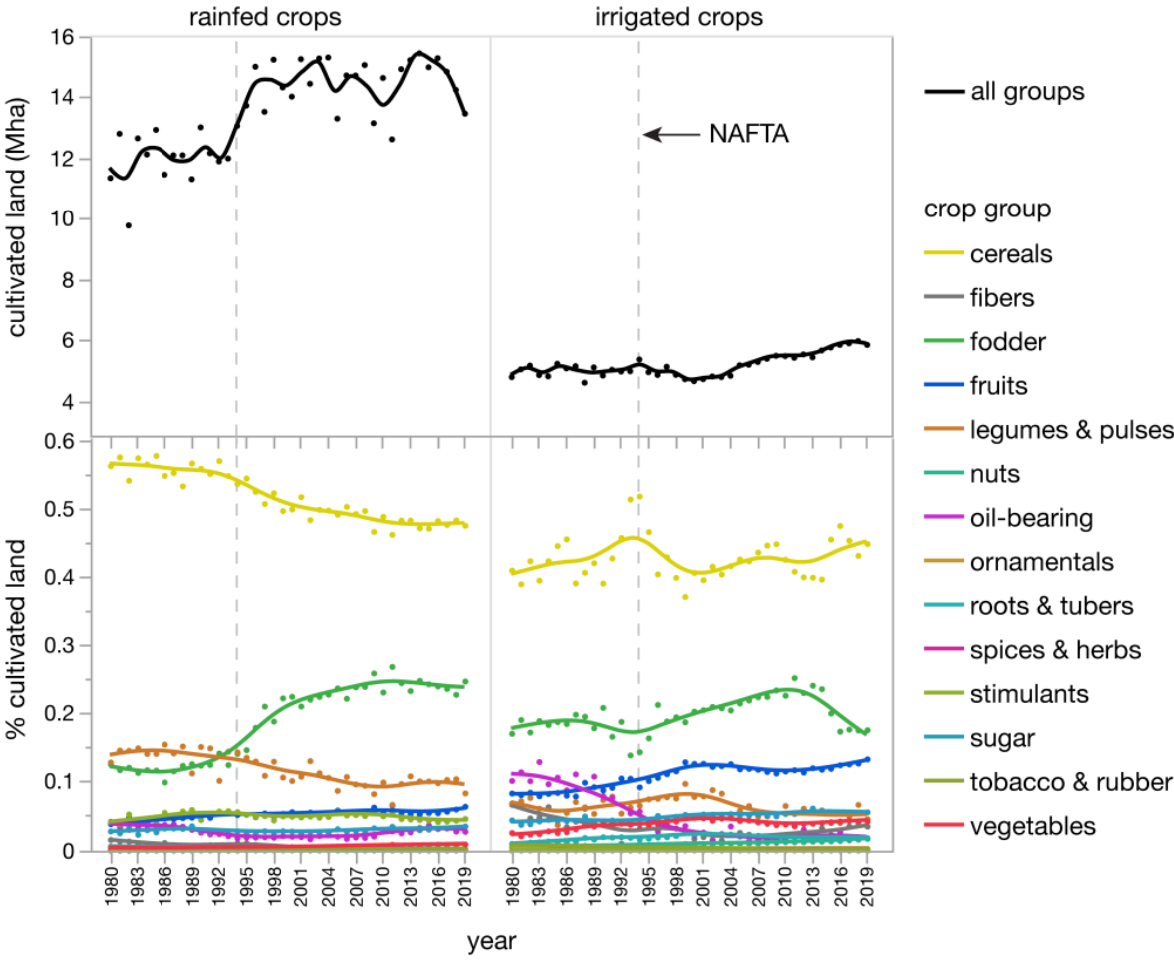
Figure 1. Rainfed and irrigated cropland areas in Mexico for each crop group from 1980 to 2019. Smoother line fit with cubic spline (λ = 0.05). Dashed line marks implementation of the North American Free Trade Agreement (NAFTA) in 1994.